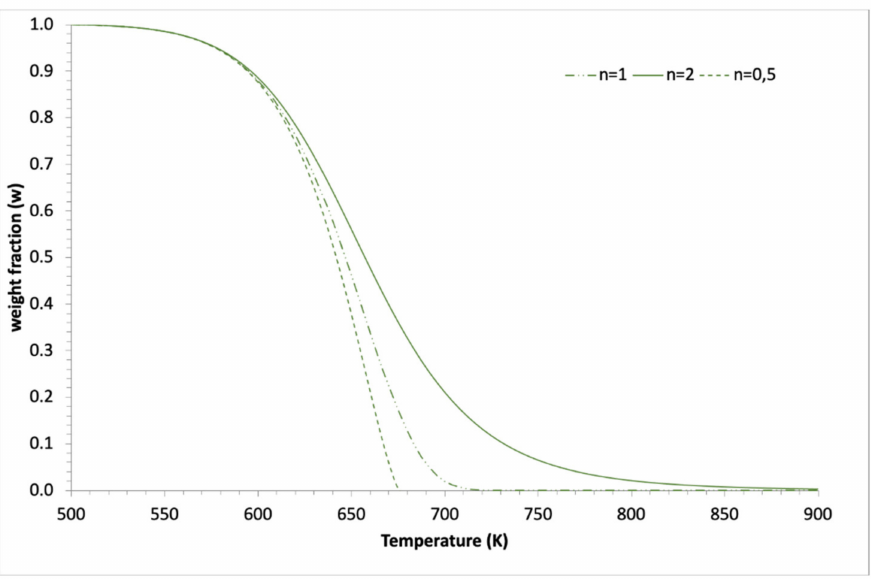
Figure 2. Effect of the reaction order on the position and shape of the decomposition curve at a fixed heating rate of 10